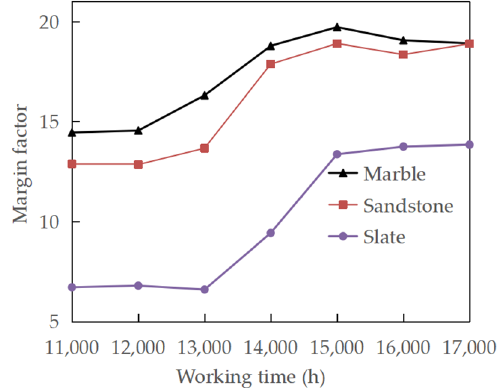
Figure 16. Curve of margin factor with time.